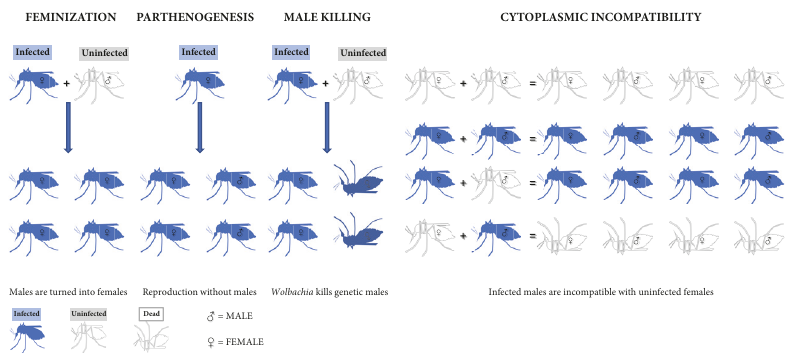
Figure 3: Different phenotypes of Wolbachia ’s host reproductive manipulation.